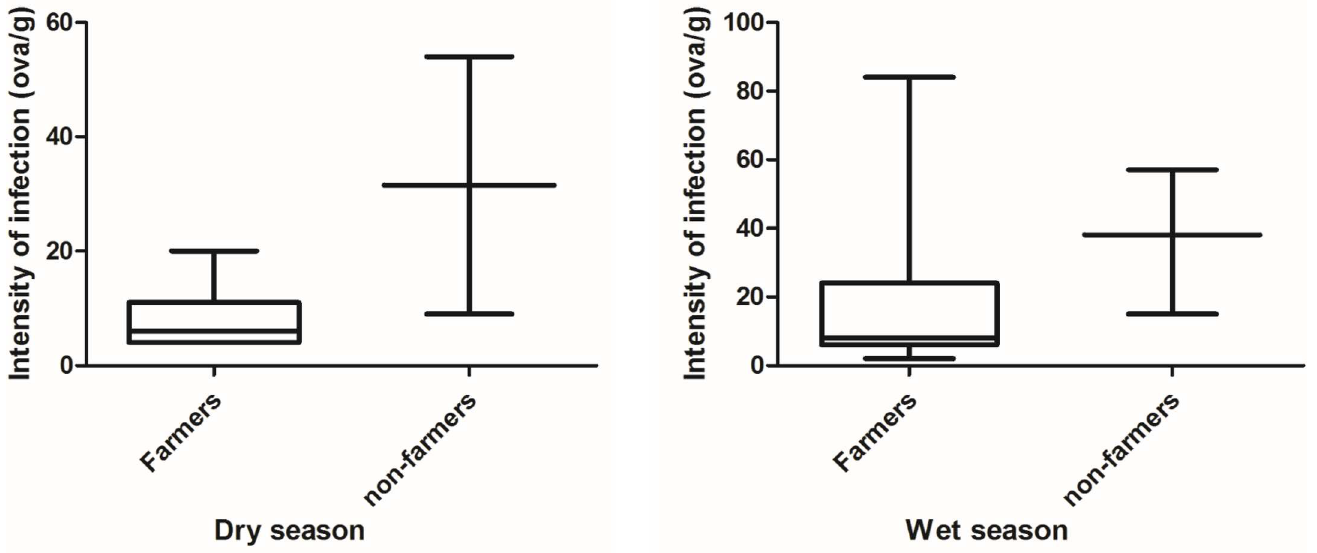
Fig 5. Distribution of hookworm infection intensity for farmersand non-farmers in both